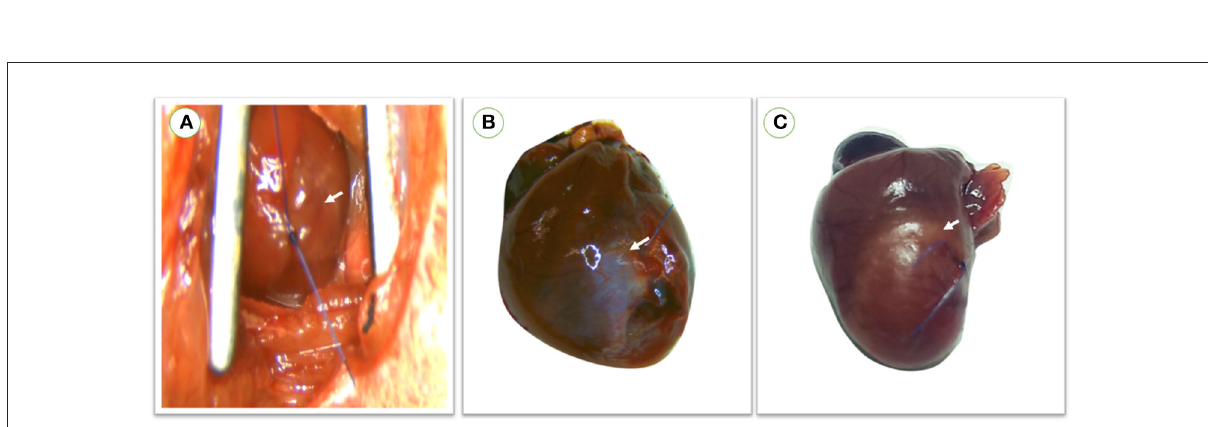
FIGURE4 (A) During operation, myocardial infarction was confirmed in rats directly after LAD ligation through apparent blanching and cyanosis of the anterior wall of the left ventricle and swelling of the left atrium. (B) Color change of the left ventricular wall in survived rats which were maintained for 1 month with a small infarction size. (C) Large infarction size was observed in rats within 24h following MI induction. red arrow; the site of infarction.